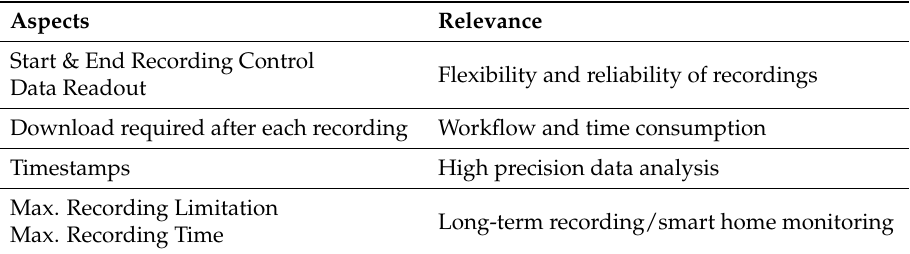
Table 2. Recommended aspects of data collection for filtering